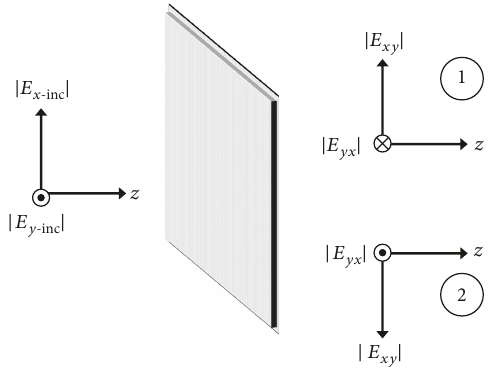
Figure 1: Working principles of a linear polarization converter device.